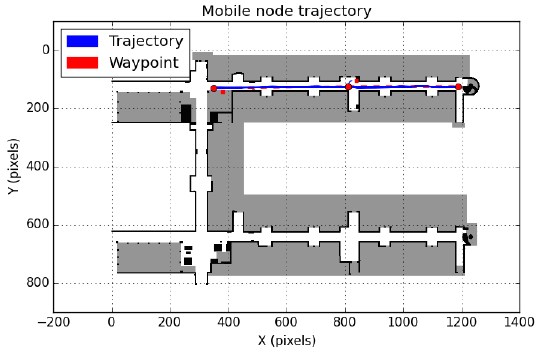
Figure 4. Trajectory of mobile node in Grenoble Experimentations take place on two di ff erent loca- tions (Grenoble and Strasbourg) providing di ff